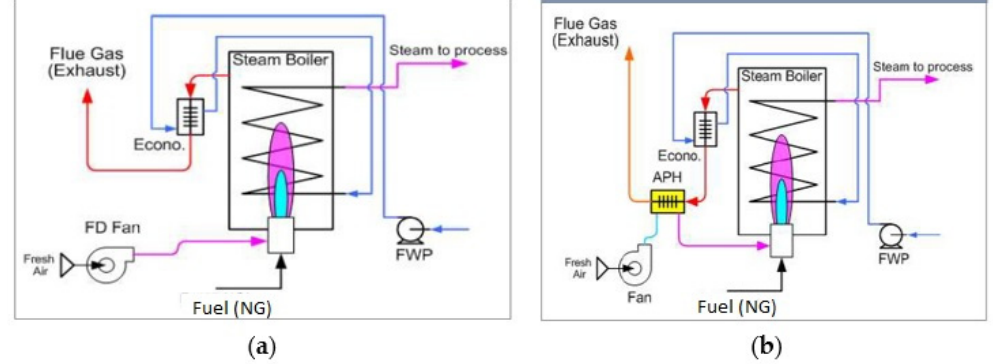
Figure 2. Heat integration approach to the production plant boiler system. ( a ). The common setup of a boiler system for a palm oil processing plant; ( b ) proposed addition of an air preheater (APH) for heat exchange between hot flue gas and fresh air.